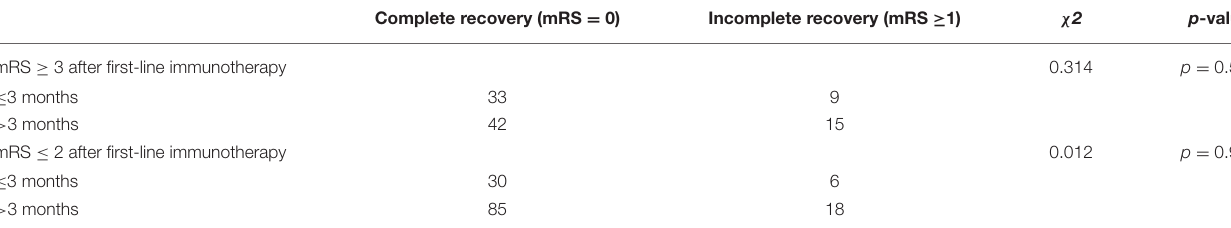
TABLE 4 | Comparison of effects of long-term and short-term prednisolone on patient